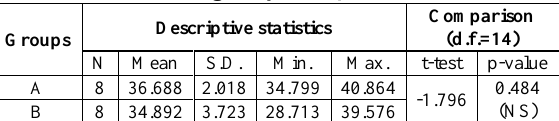
Figure 5:Digital image captured by Dino- Lite digital microscope.